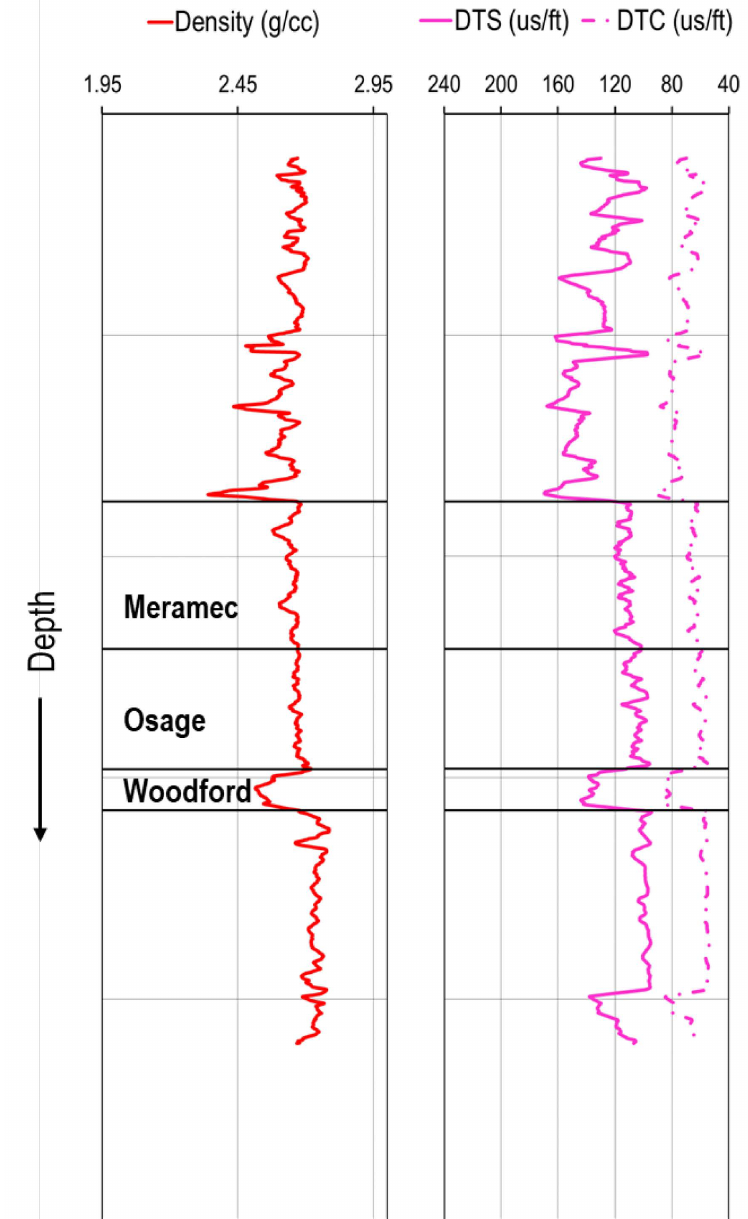
Figure 14. From left to right, density log, compressional slowness, and shear slowness variation with